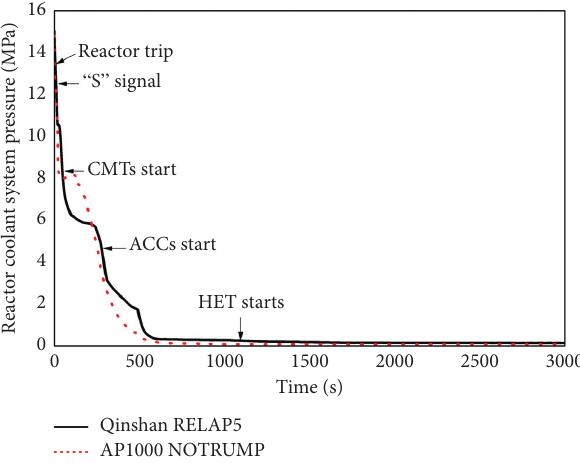
Figure 19: DEDVI line break RCS pressure.